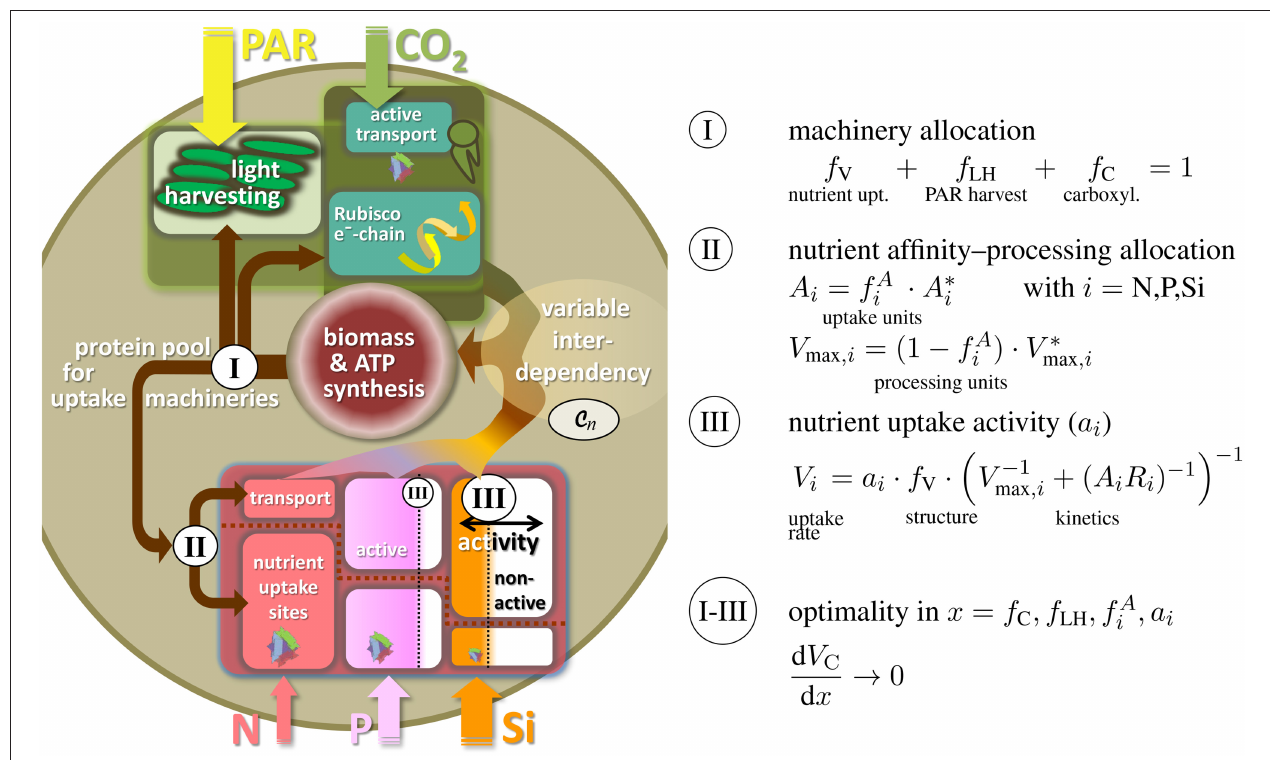
FIGURE 2 | Three-level regulation of uptake systems in unicellular autotrophs: (I) Protein allocation to photosynthetic vs. nutrient uptake machinery, with the photosynthetic apparatus being further divided into light harvesting and Rubisco/electron-chain; (II) allocation of transport proteins vs. uptake sites or, analogously, between transport/processing and affinity; (III) regulation in nutrient uptake activity. Both, ambient resource concentration C i and adaptive responses in ecophysiological traits x = f C , f LH , f A i , a i determine the internal resource availabilities q i , which through the flexible co-limitation function C n determine biomass synthesis rate, here expressed as the carbon and energy/ATP turnover V C